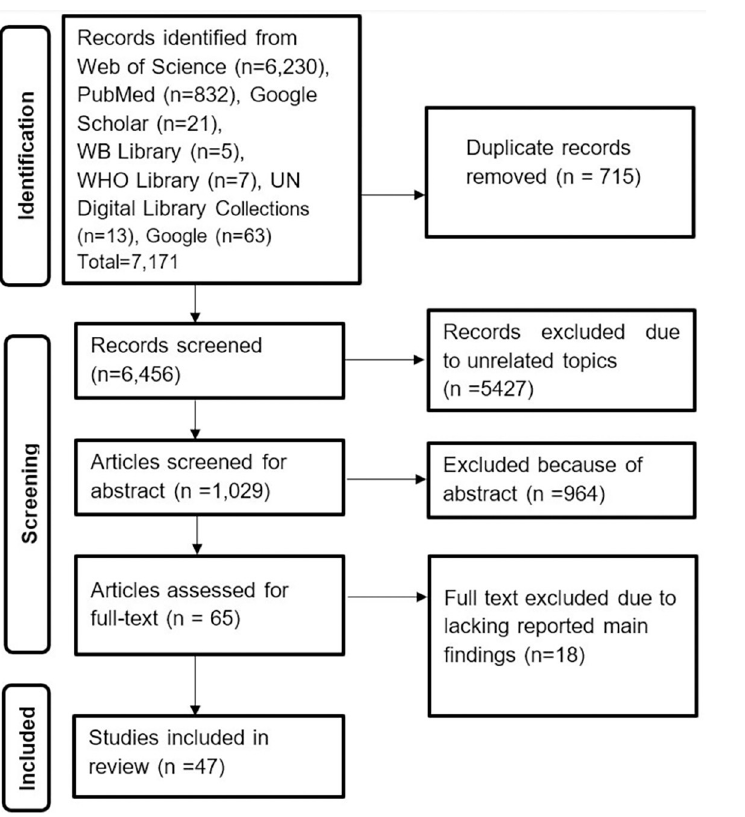
Fig 1. PRISMA-ScR flow diagram for articles selection